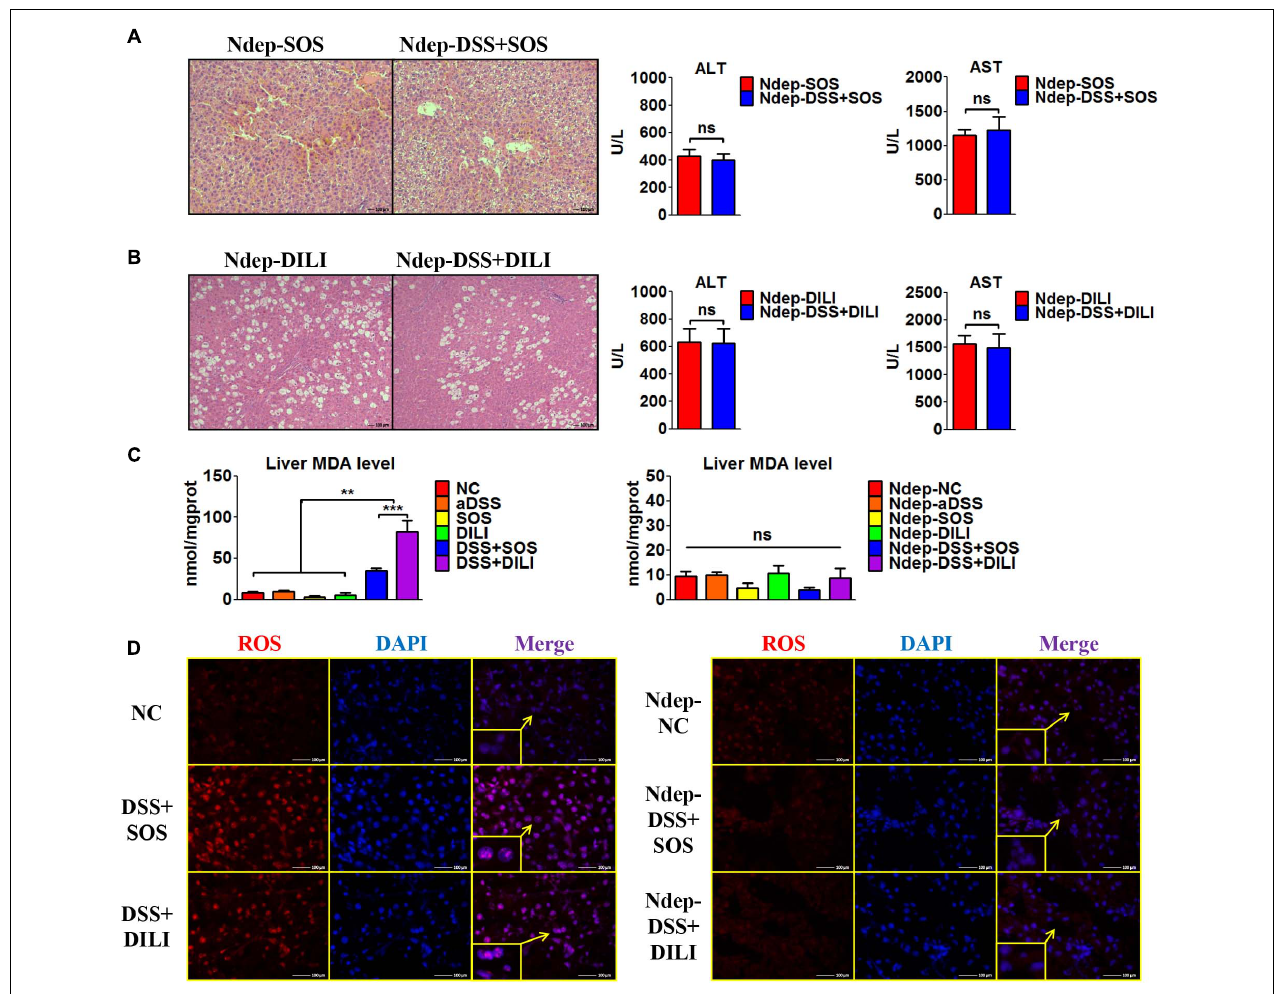
FIGURE 3 | Neutrophil depletion abrogates colitis-induced liver injury. In the sinusoidal obstruction syndrome (SOS) model and the drug-induced liver injury (DILI) model, neutrophils were depleted (Ndep) and experiments were repeated. (A) H&E staining of Ndep-SOS model and liver enzymes [including alanine aminotransferase (ALT) and aspartate aminotransferase (AST)] showed that dextran sulfate sodium (DSS) colitis could no longer aggravate liver injury. (B) Similar results were found in the DILI model. (C) The malondialdehyde (MDA) level in the liver showed a similar trend change with the number of hepatic neutrophils. (D) Immunofluorescence staining of reactive oxygen species (ROS) (red) also showed good correlation with the number of hepatic neutrophils. ns, non-significant; ** p < 0.01; *** p < 0.001 by one-way ANOVA; n = 6 in each group; panels A to C are representative of three experiments; panel D is representative of two